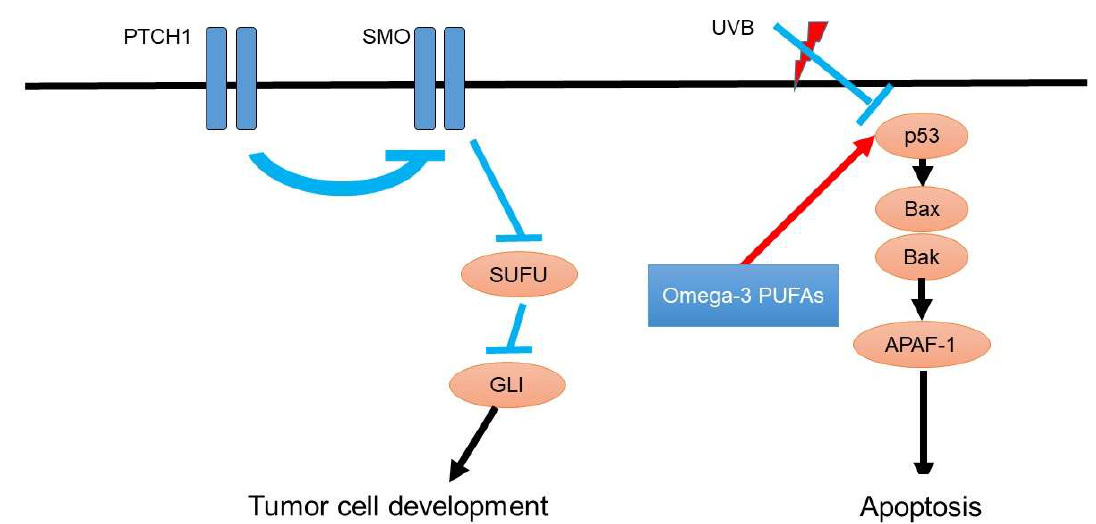
Figure 2. Oncogenesis signaling of basal cell carcinoma and possible roles of omega-3 PUFAs. As the detailed oncogenesis of basal cell carcinoma, hedgehog pathway gene mutation activates patched homolog and smoothened homolog, which are responsible for the development of basal cell carcinoma. P53 is suppressed by ultraviolet light exposure, leading to the suppression of apoptosis of basal cell carcinoma.